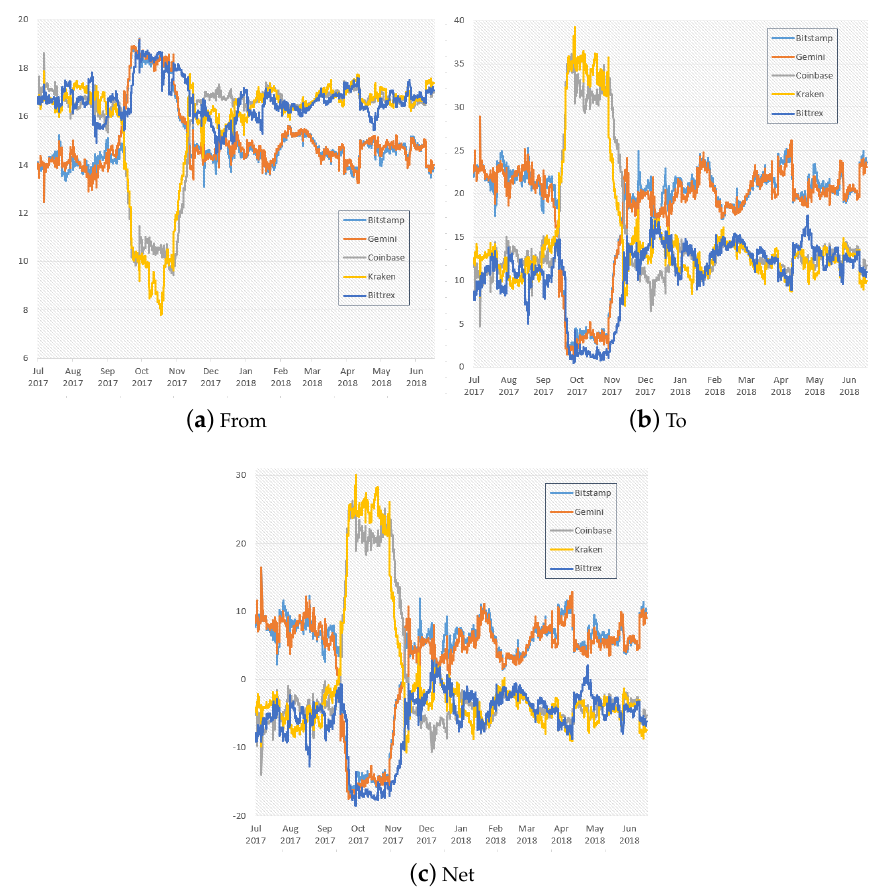
Figure 4. Directional Spillover Indexes (DSI). Note : The figure shows the directional return spillover indexes “from” others ( a ) and “to” others ( b ), as well as the net ones ( c ). The rolling window set for the estimations is 336 h—corresponding to two weeks. Values are expressed in percentage